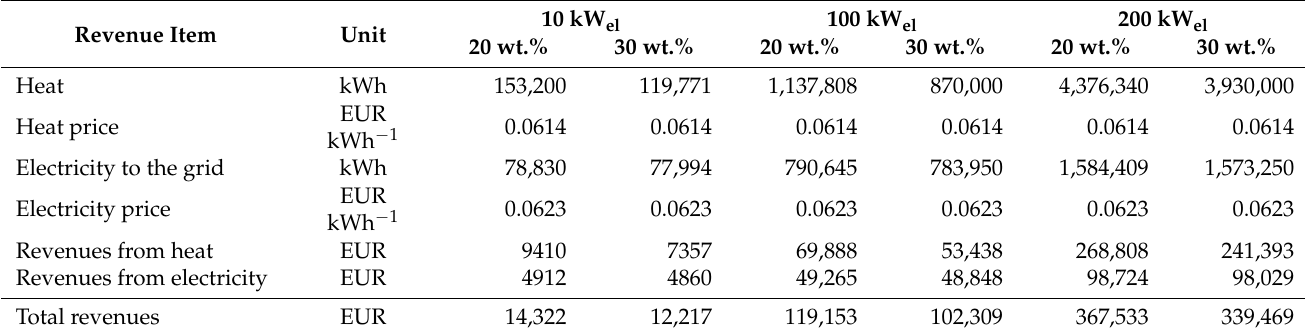
Table 7. Revenue items from heat and electricity in individual variants.